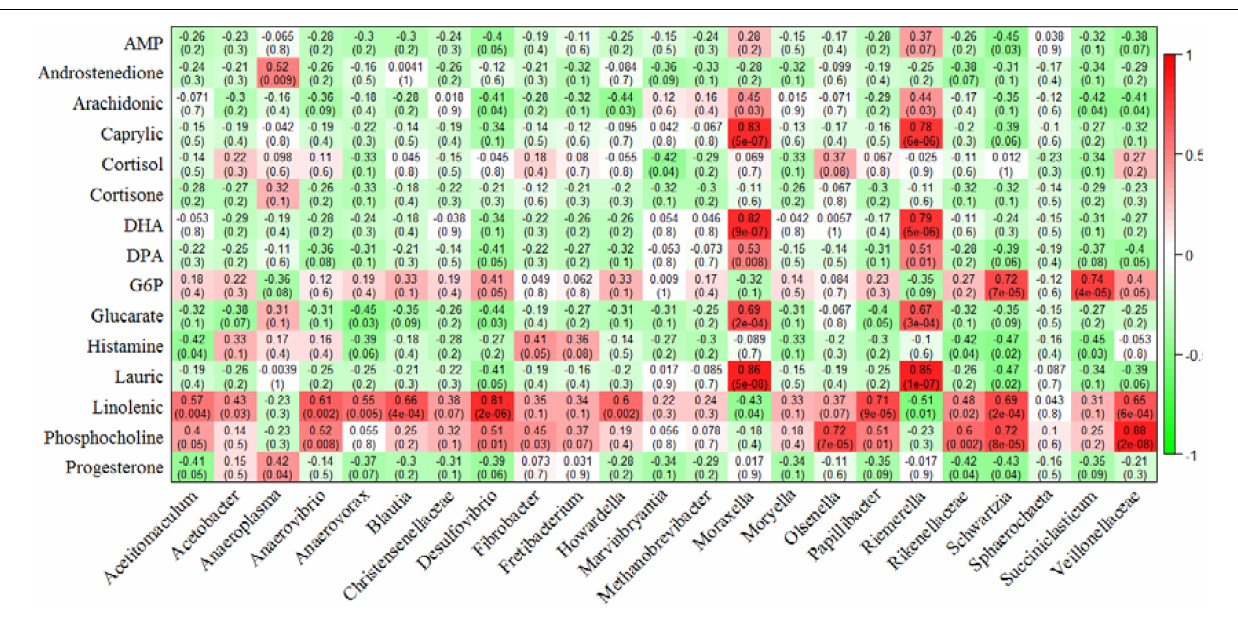
FIGURE 6 | Correlation analysis of rumen microorganisms with beef glycolipid metabolite concentrations. Each cell contains the corresponding correlation and P -value. The table is color-coded by correlation according to the color legend. AMP, adenosine monophosphate; DHA, docosahexaenoic acid; DPA, docosapentaenoic acid; G6P,